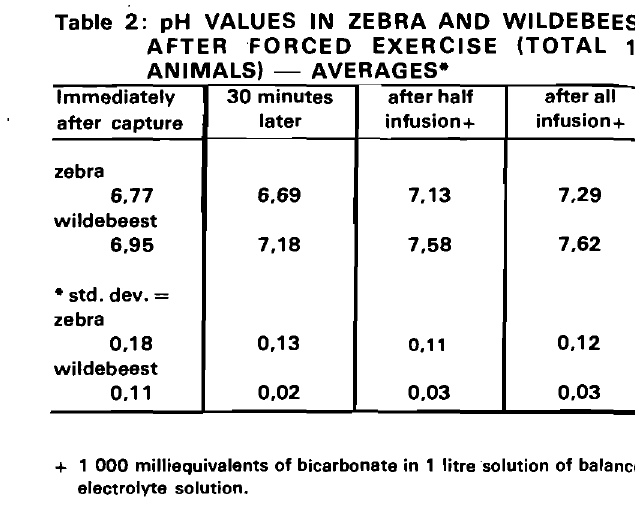
Table 4: ENZYME, VALUES IN ZEBRA AND WILDEBEEST AFTER FORCED EXERCISE (TOTAL 12 ANIMALS) -